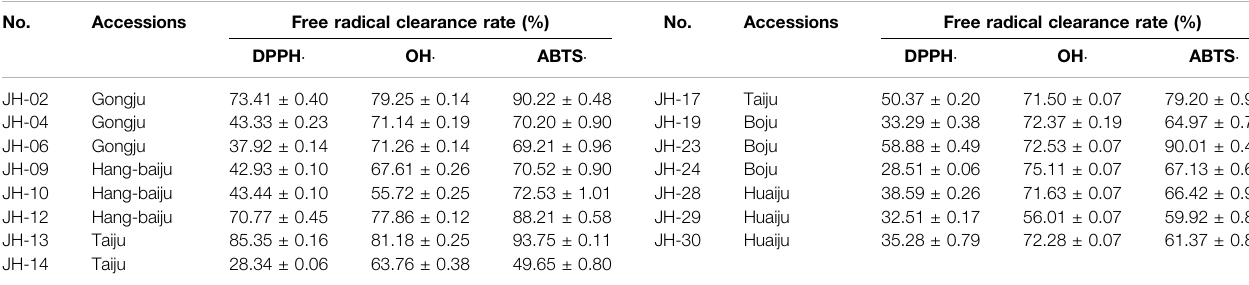
TABLE 6 | Free radical scavenging rate of different species of CMs ( n = 3).